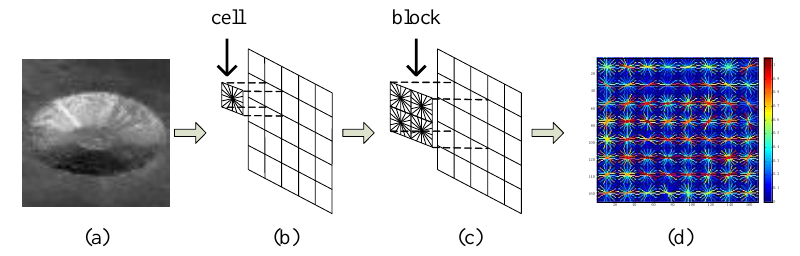
Figure 2 The flow chart of HOG feature